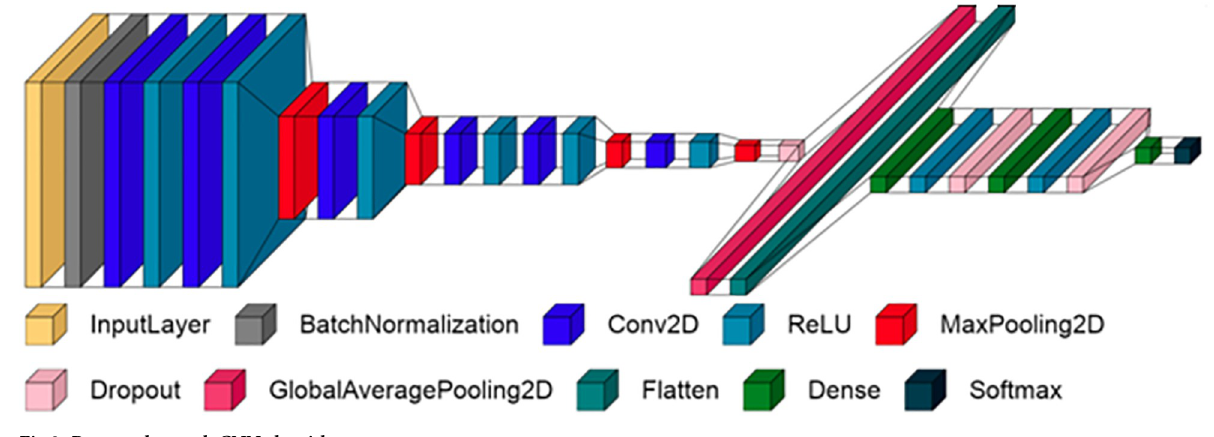
Fig 3. Proposed scratch CNN